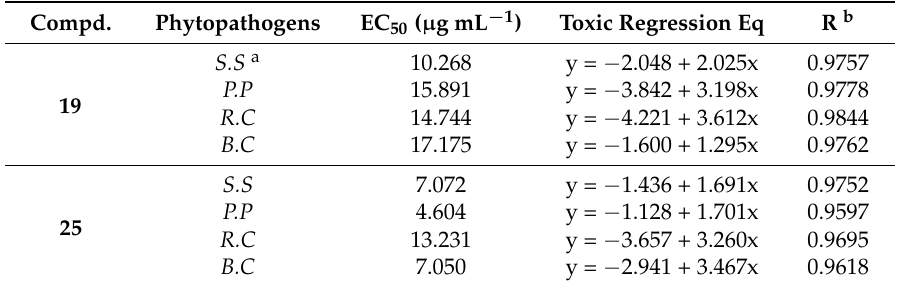
Table 3. Inhibitory Effects of Compounds 19 and 25 against Phytopathogenic Fungi. Compd.